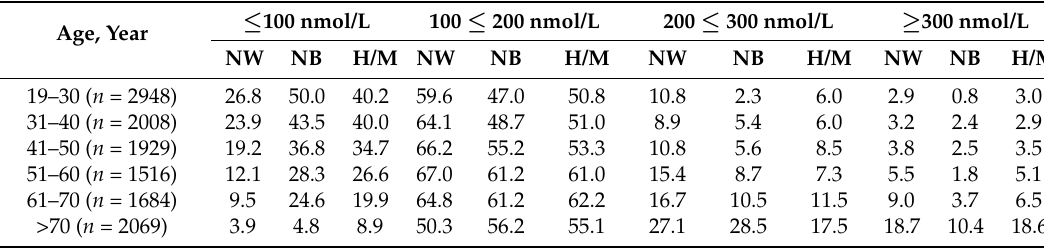
1 Same as Table 1. n = 12,154. Sub-group analysis was performed on adult population only (age 19 years or older). 2 Abbreviations: NW, non-Hispanic white; NB, non-Hispanic black; H/M, Hispanic/Mexican. 3 Prevalence were age-specific and race-specific.